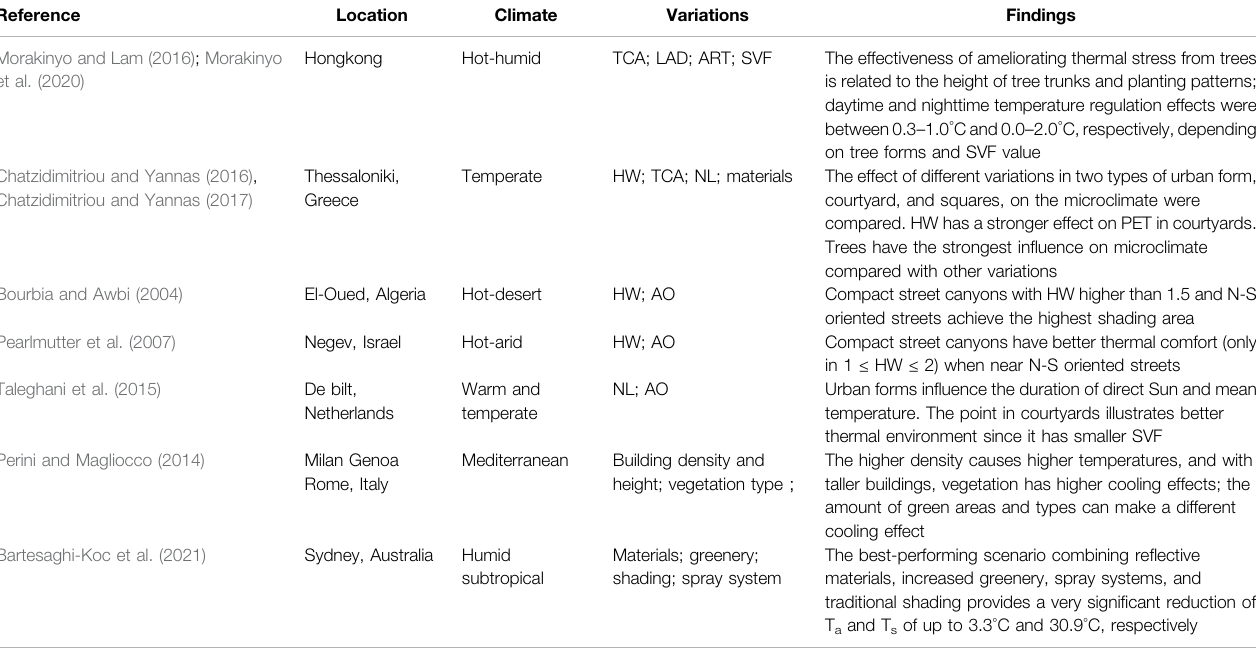
TABLE 1 | Studies on the synergistic effect in different parameters on outdoor thermal comfort.